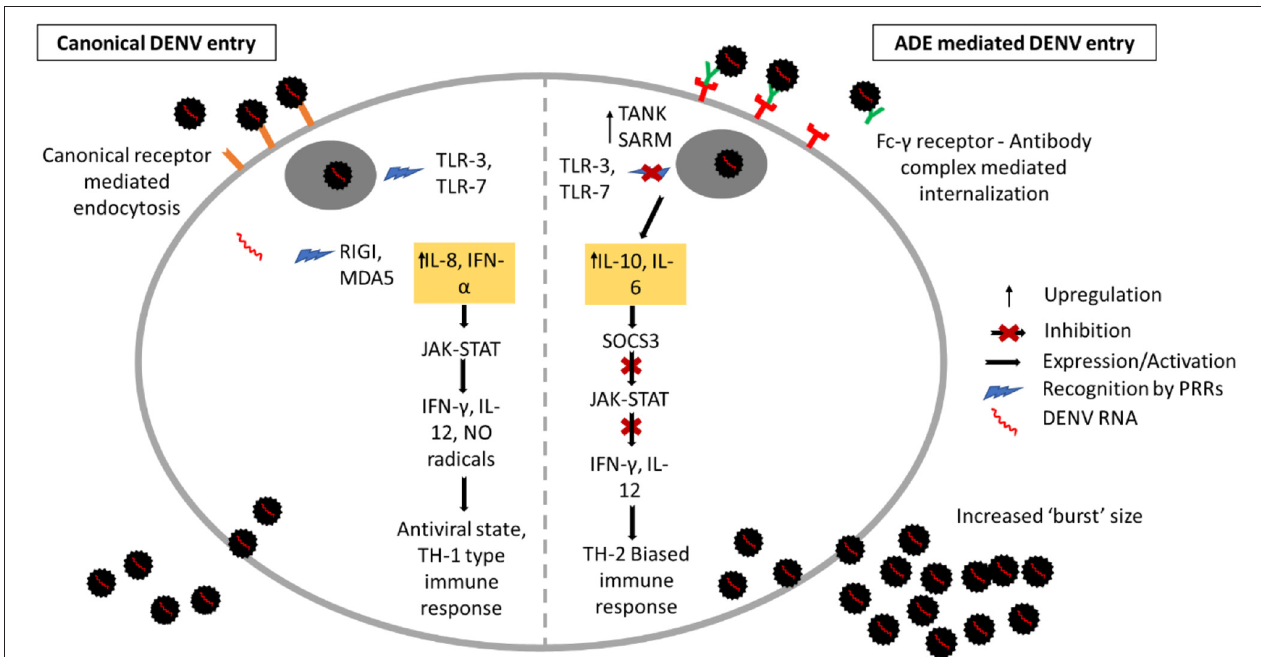
FIGURE 1 | Innate immune response during ADE and non-ADE dengue infection. Canonical non-ADE mediated entry occurs via receptor-mediated endocytosis. Upon entry, the DENV particles are internalized in endosomes and are recognized by the pathogen recognition receptors TLR-3 and 7. Release of viral RNA from endosomes is recognized by RIGI and MDA5 which triggers production of pro-inflammatory cytokines IFN- γ and IL-8. This activates the JAK/STAT pathway resulting in expression of IFN- γ , IL-12, and Nitric Oxide radicals. Virus entry via Fc γ R-antibody in dengue-ADE caused expression of TANK and SARM which inhibits TLR signaling. Production of anti-inflammatory cytokines IL-10 and IL-6 ensues and expression of SOCS3 as a result inhibits JAK/STAT pathway. This results in inhibition of pro-inflammatory cytokine production and causing a TH-2 biased immune response and increased “burst”